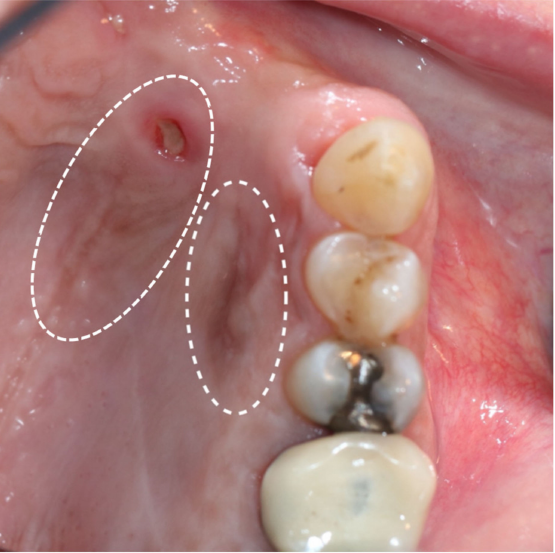
Figure 6. Second recurrence of OMM: irregular, light-brown changes and a fibrin-covered ulceration in the palatal mucosa are evident (white circles).